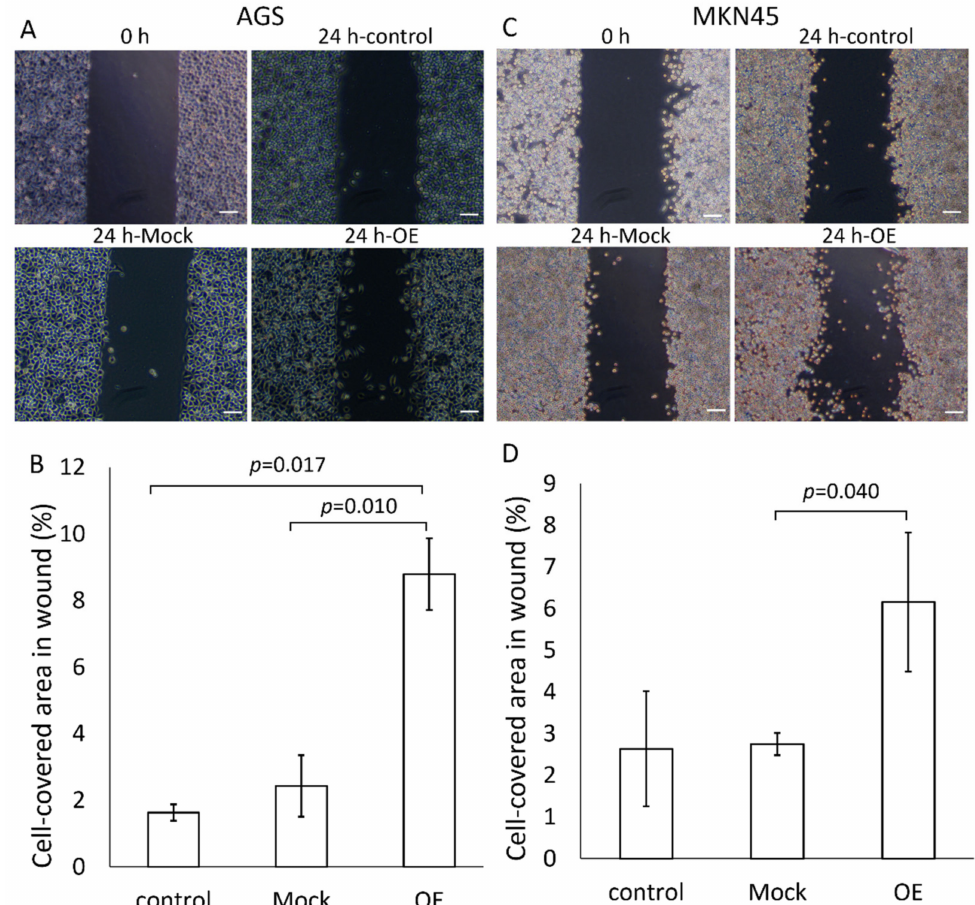
Figure 4. Wound healing assays (migration capability and proliferation capability) of AGS and MKN45 after treatment with GRP78-containing exosomes. ( A ) Typical pictures 24 h later of wound healing assays for AGS after application of exosomes derived from AGS mock and GRP78-OE cells. For control experiments, PBS was used instead of GRP78-containing exosomes. Scale bars, 100 µ m. ( B ) Typical pictures 24 h later of wound healing assays for MKN45 after application of exosomes derived from MKN45 mock and GRP78-OE cells. For control experiments, PBS was used instead of GRP78-containing exosomes. Scale bars, 100 µ m. ( C , D ) Summarized data for ( A ) and ( B ), respectively. n = 3